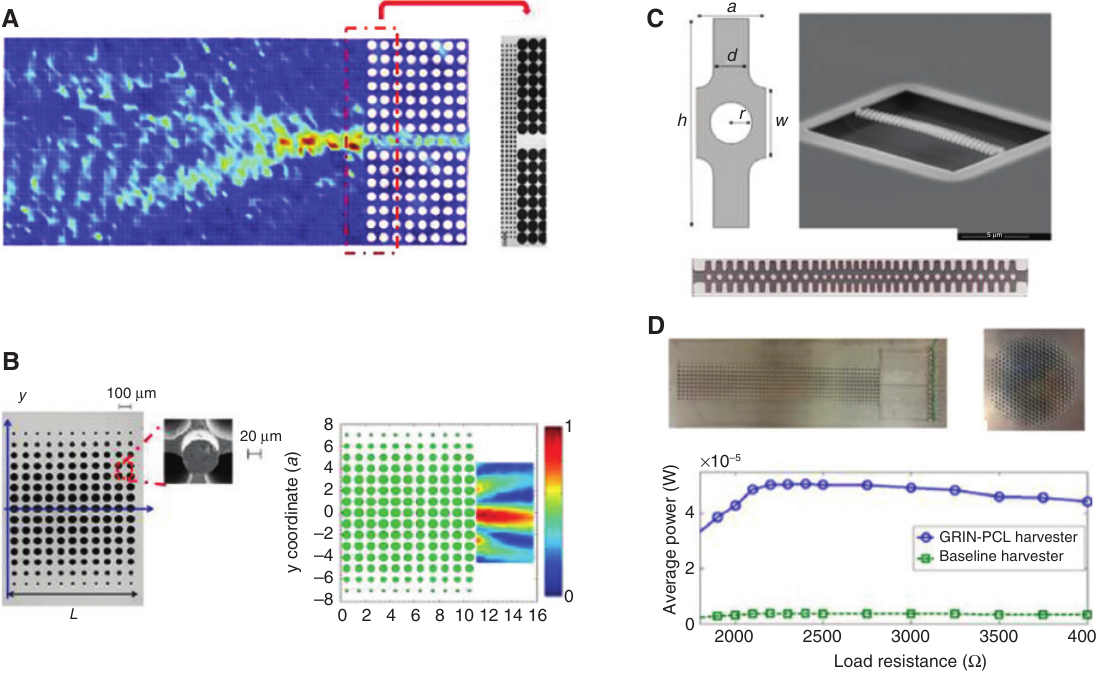
Figure 7: GRIN devices for flexural waves. (A) Acoustic waveguide by combining GRIN flat lens and phononic crystals in an 80 μ m thick plate. SEM image shows samples in the rectangular dotted box with the radii of gradient holes varying from 15 μ m to 25 μ m [96]. (B) Acoustic metalens by combining GRIN flat lens and pillars (30 μ m radius) to exhibit the near-field subdiffraction focusing [68]. (C) 1D phoxonic crystal with varied unit cells (the minimum radius of holes is 100 nm) to exhibit the optomechanical interactions [78]. (D) GRIN flat rectangular lens and Luneburg circular lens for energy harvesting [71,